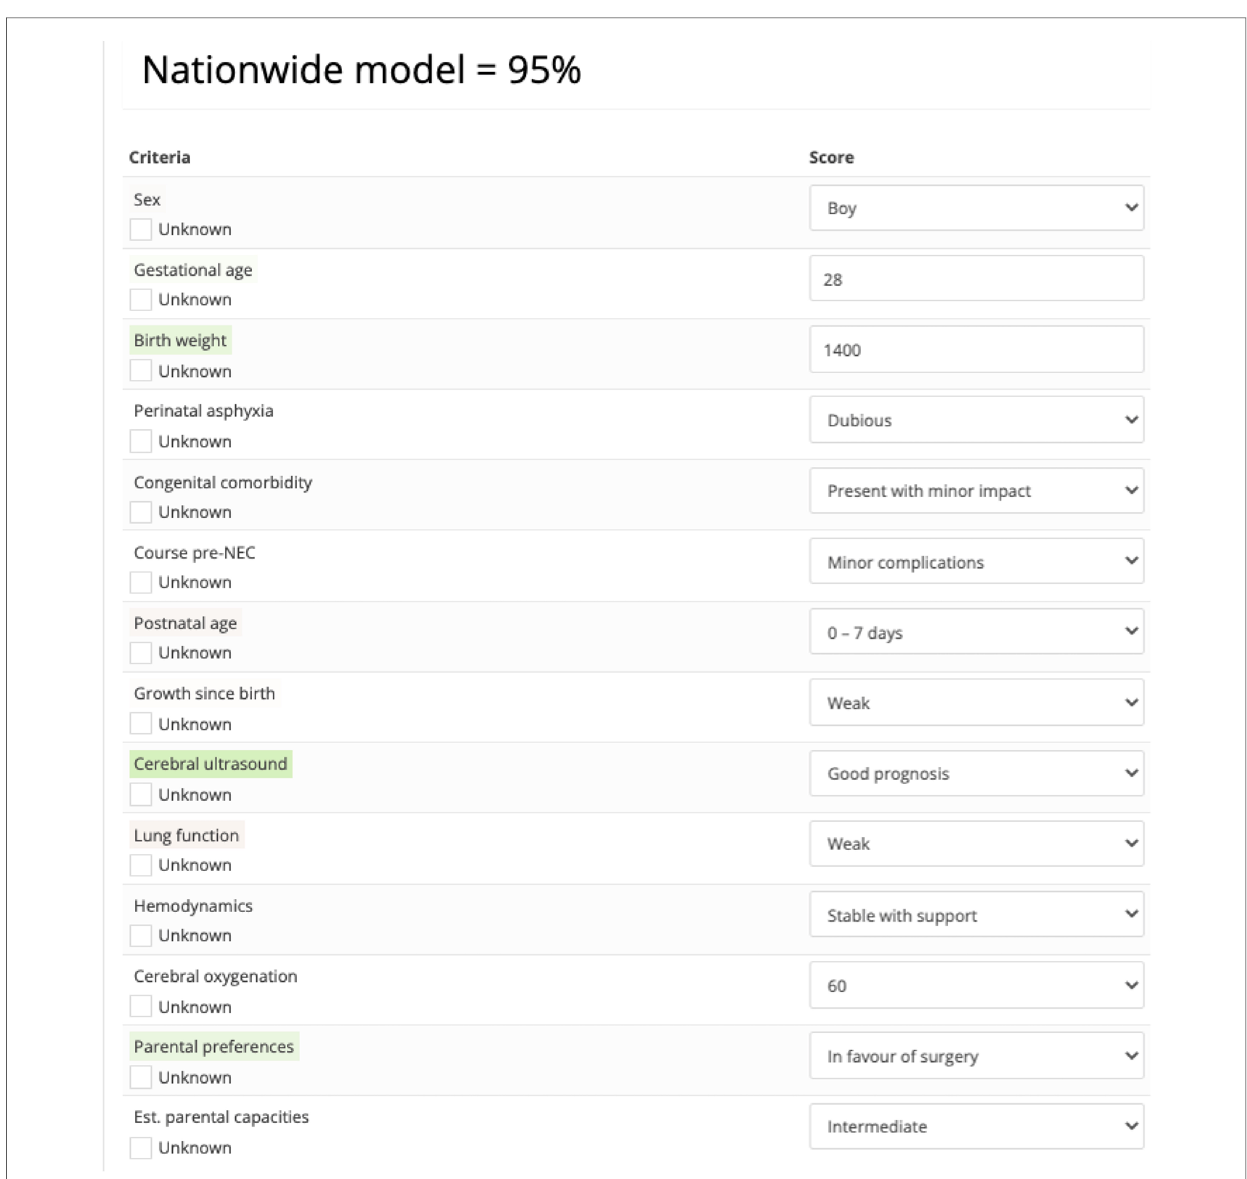
FIGURE 2 Example of an assessment generated by the nationwide choice model stating that the probability that a randomly sampled expert from the expert group would recommend to perform surgery on a patient with this pro fi le equals 95%. Color coding highlights which factors had a positive or negative contribution to the